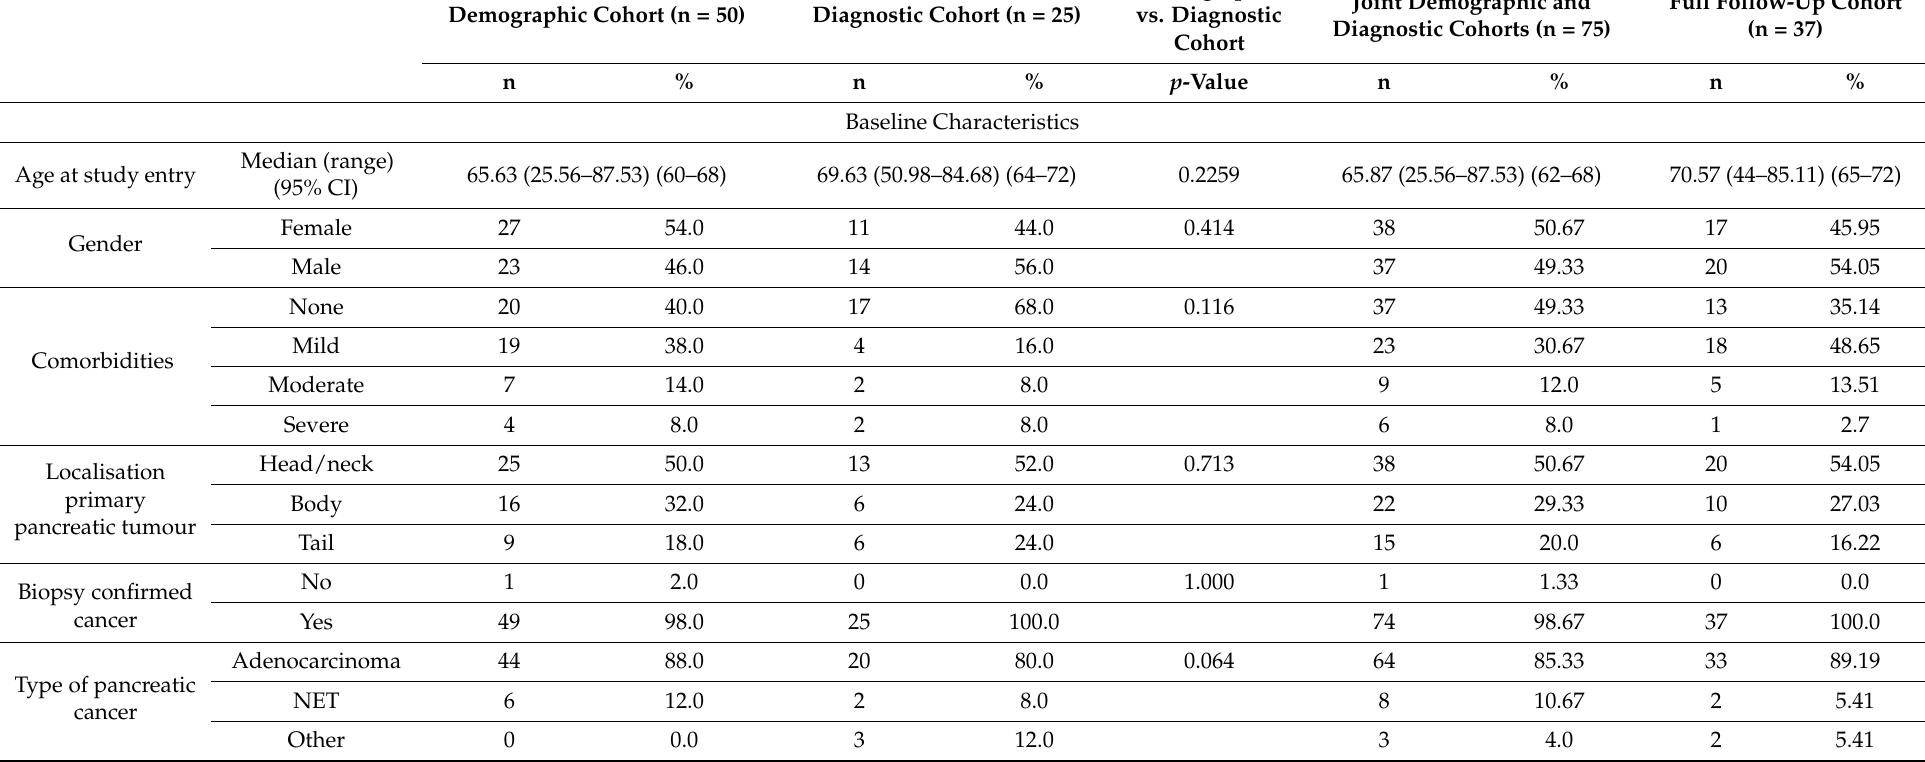
Table 1. Baseline characteristics and details on treatment administered and patient outcomes. To compare the demographic and diagnostic cohorts, T-Tests and Chi square of Fish were utilised (excluding missing values). Abbreviations: CisGem, cisplatin Capecitabine; CI, confidence interval; ECOG PS, Eastern Cooperative Oncology Group Performance Status; FOLFOX, Foloni acid, fluorouracil and oxaliplatin; GemCap, gemcitabine capecitabine; GemNabPaclitaxel, Gemcitabine Nab-paclitaxel; Ki67, nuclear protein 67; NET, neuroendocrine tumour; SSA, somatostatin analogue; TemCap, Temozolomide-capecitabine. * other types of chemotherapy